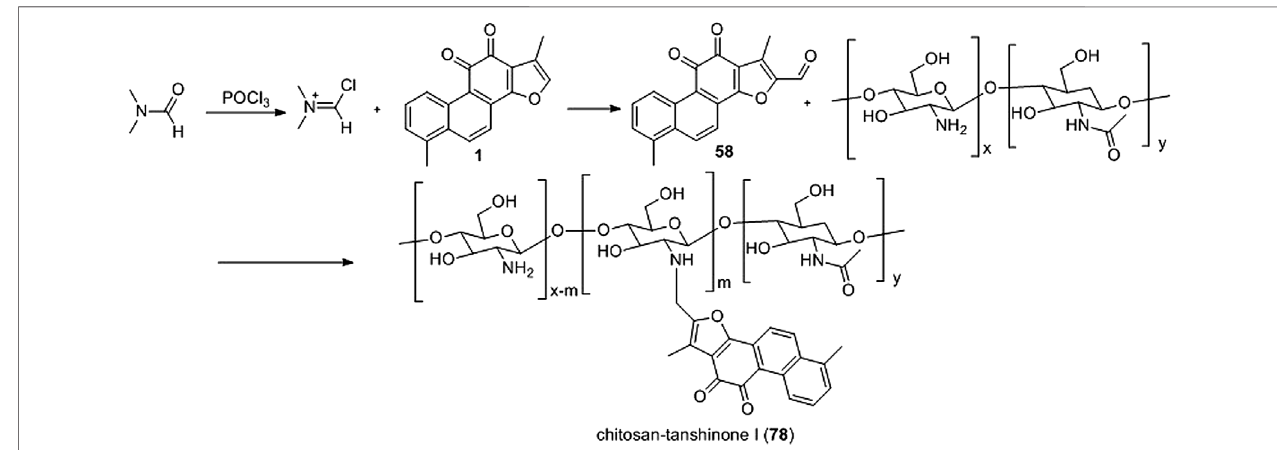
FIGURE 9 | Synthetic chitosan-tanshinone I ( 78